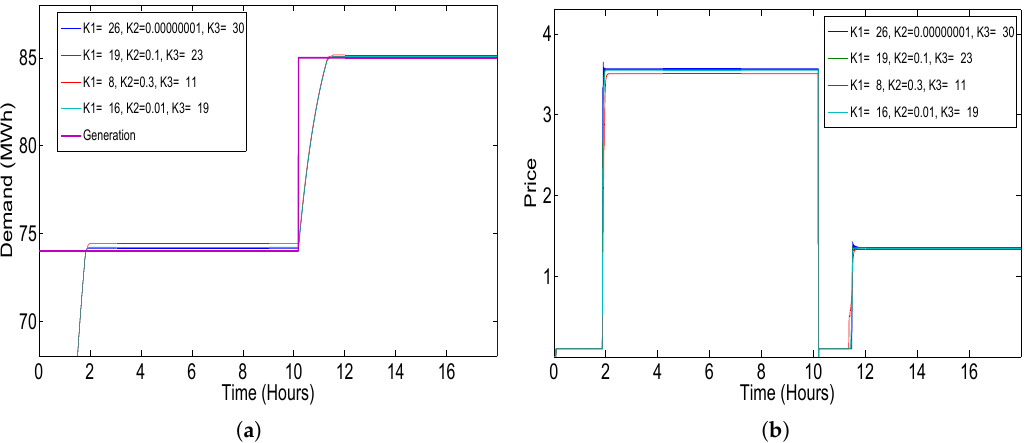
Figure 9. Demand and price response of the proposed model to step signal for various coefficients K1, K2 and K3 of STSMC: ( a ) demand response; ( b ) price response.